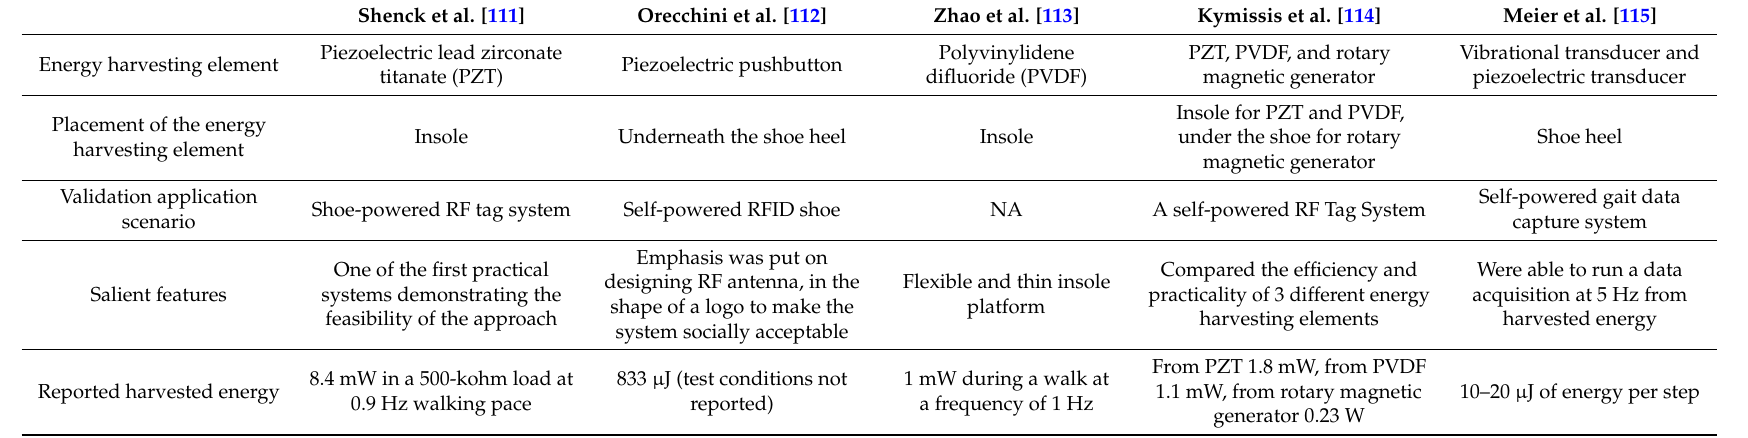
Table 7. Comparison of footwear-based energy harvesting